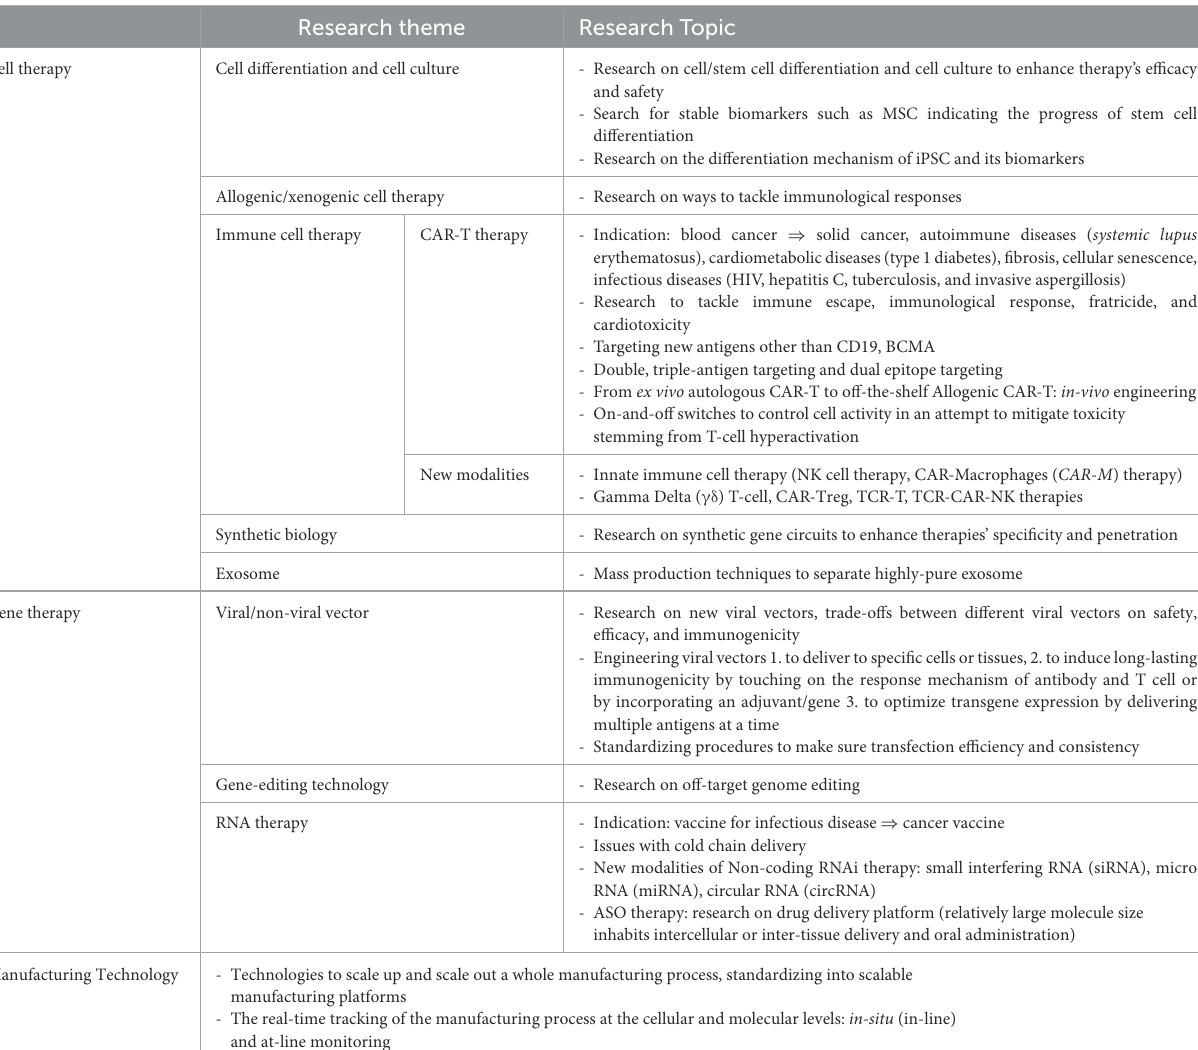
TABLE 1 Major research and development themes of cell and gene therapies